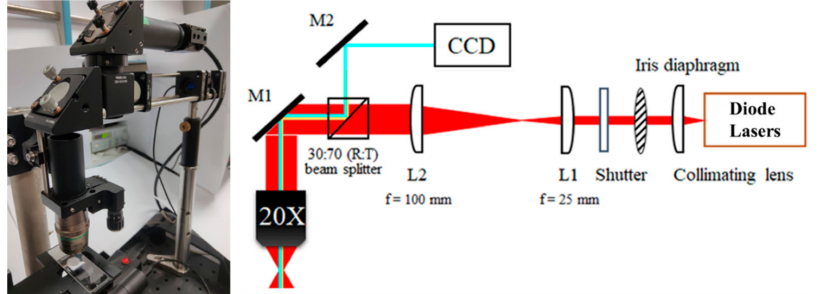
Figure 1. The experimental setup for the proposed LLLT illumination system consists of diode lasers at wavelengths of 450 nm, 520 nm, and 633 nm, respectively, laser-focusing optics (20 × objective lens), an electrical shutter, and a specimen holder attached to the xyz -axis steel